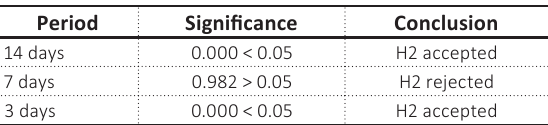
Table 5. Average abnormal return differential test